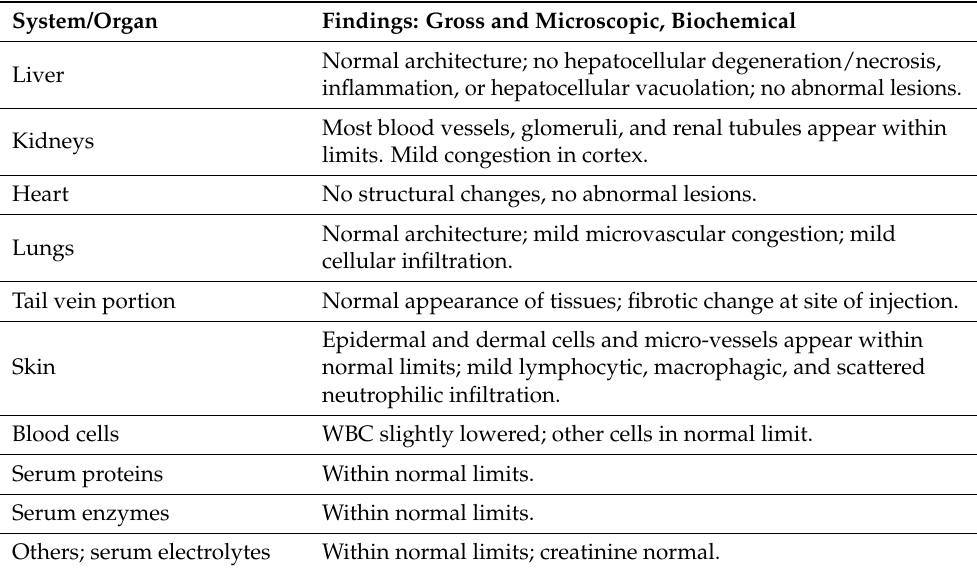
Table 1. The macroscopic and microscopic (histopathological) observation of vital organs on